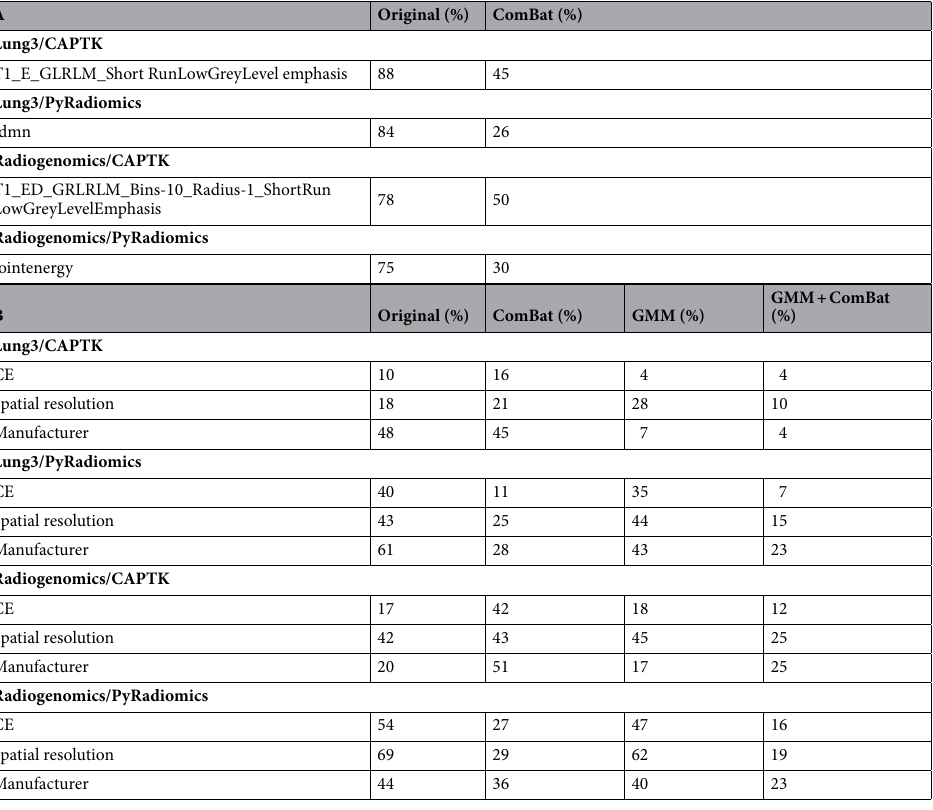
Table 2. (A) Percentage of features with significant differences in distribution before and after harmonization by the GMM groupings. Feature names indicate the feature whose distribution was used to generate the GMM scan grouping. GMM scan groupings are obtained by selecting the best GMM model from a set composed of GMM models generated from each of the features such that the final GMM scan grouping is estimated from a single feature. (B) Percentage of features with significantly different distributions attributable to batch effects in the original features and after applying standard ComBat, harmonizing by the GMM grouping alone (GMM), and harmonizing by both the GMM grouping and known imaging parameter batch effects (GMM + ComBat (CE)). Tables contain the percentage of features out of the original number of features with detected significant ( p < 0.05) differences in distribution for all batch